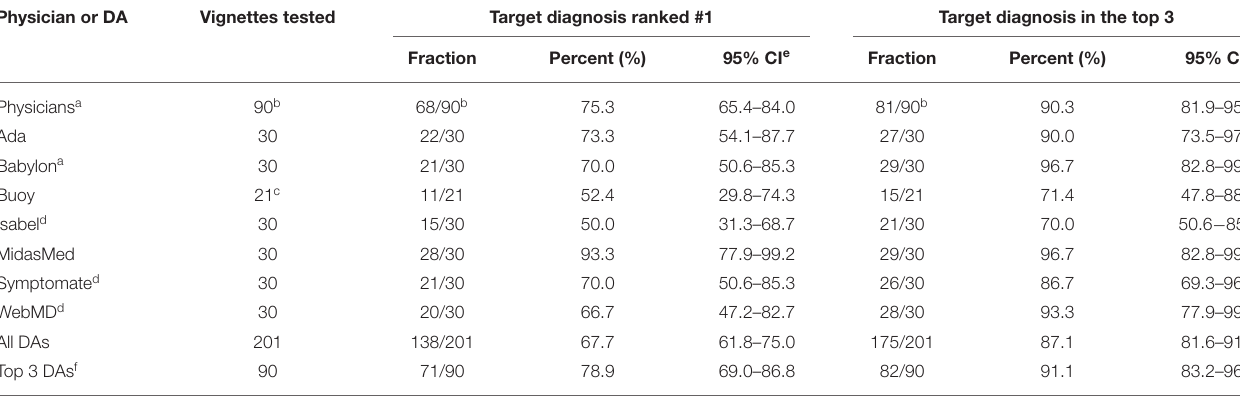
TABLE 2 | Performance comparison summary results for 7 DAs and